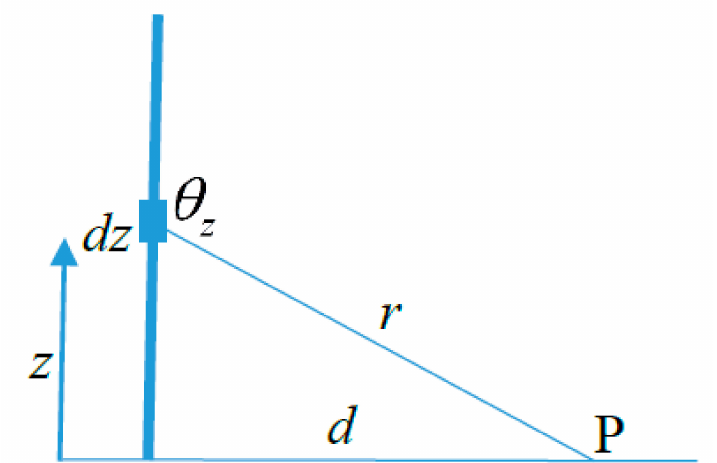
Figure 3. Geometry relevant to the calculation of electric field generated by a lightning channel located over a perfectly conducting ground plane. The channel is located along the z